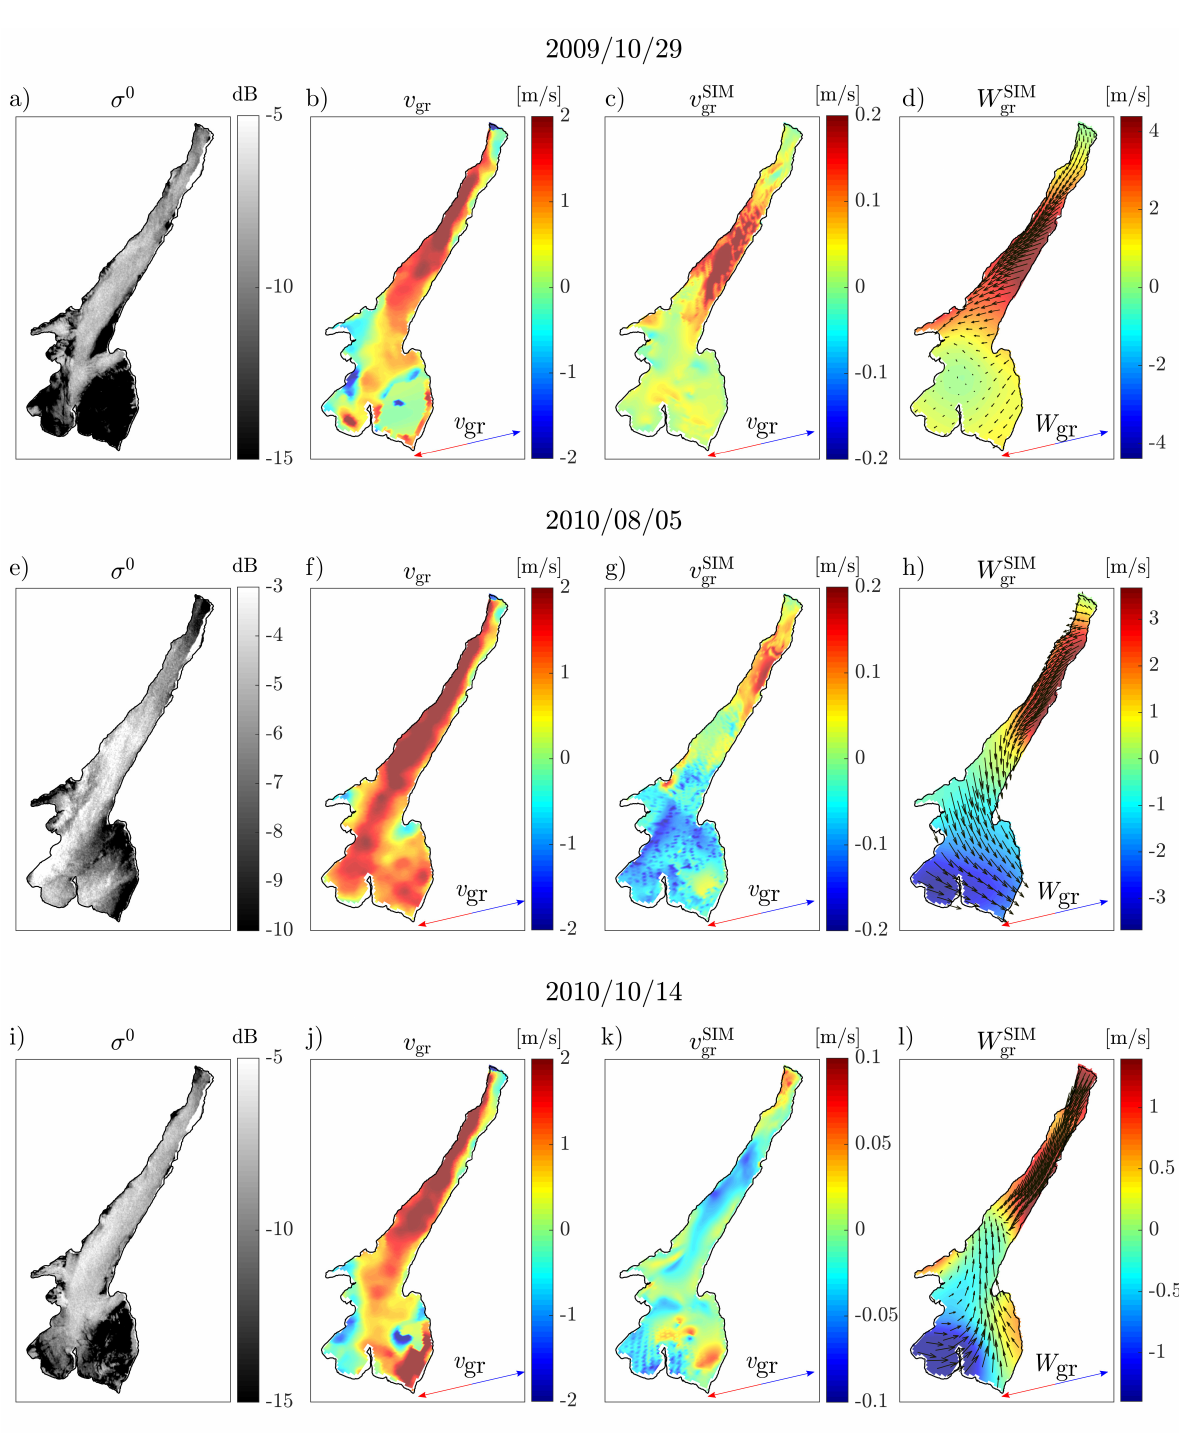
Figure 5. Maps from low wind days ( a – d ) 29 October 2009, ( e – h ) 5 August 2010, ( i – l ) 14 October 2010 of: first column ( a , e , i ) SAR bakcscatter amplitude; second column ( b , f , j ) v gr estimated from SAR DCA (Equation (2)); third column ( c , g , k ) v SIM gr simulated by the numerical model; fourth column ( d , h , l ) ground range component of simulated wind speed W SIM gr . Black arrows in fourth column indicate the wind vector. The ground range direction is displayed by the blue and red arrow at the bottom-right corner of